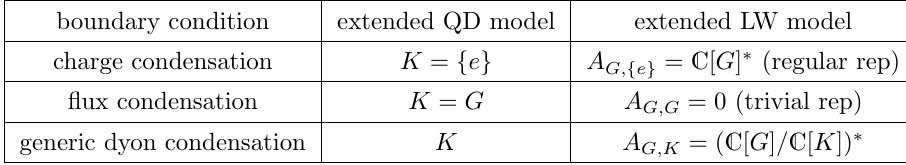
Table 1 . EM duality on the